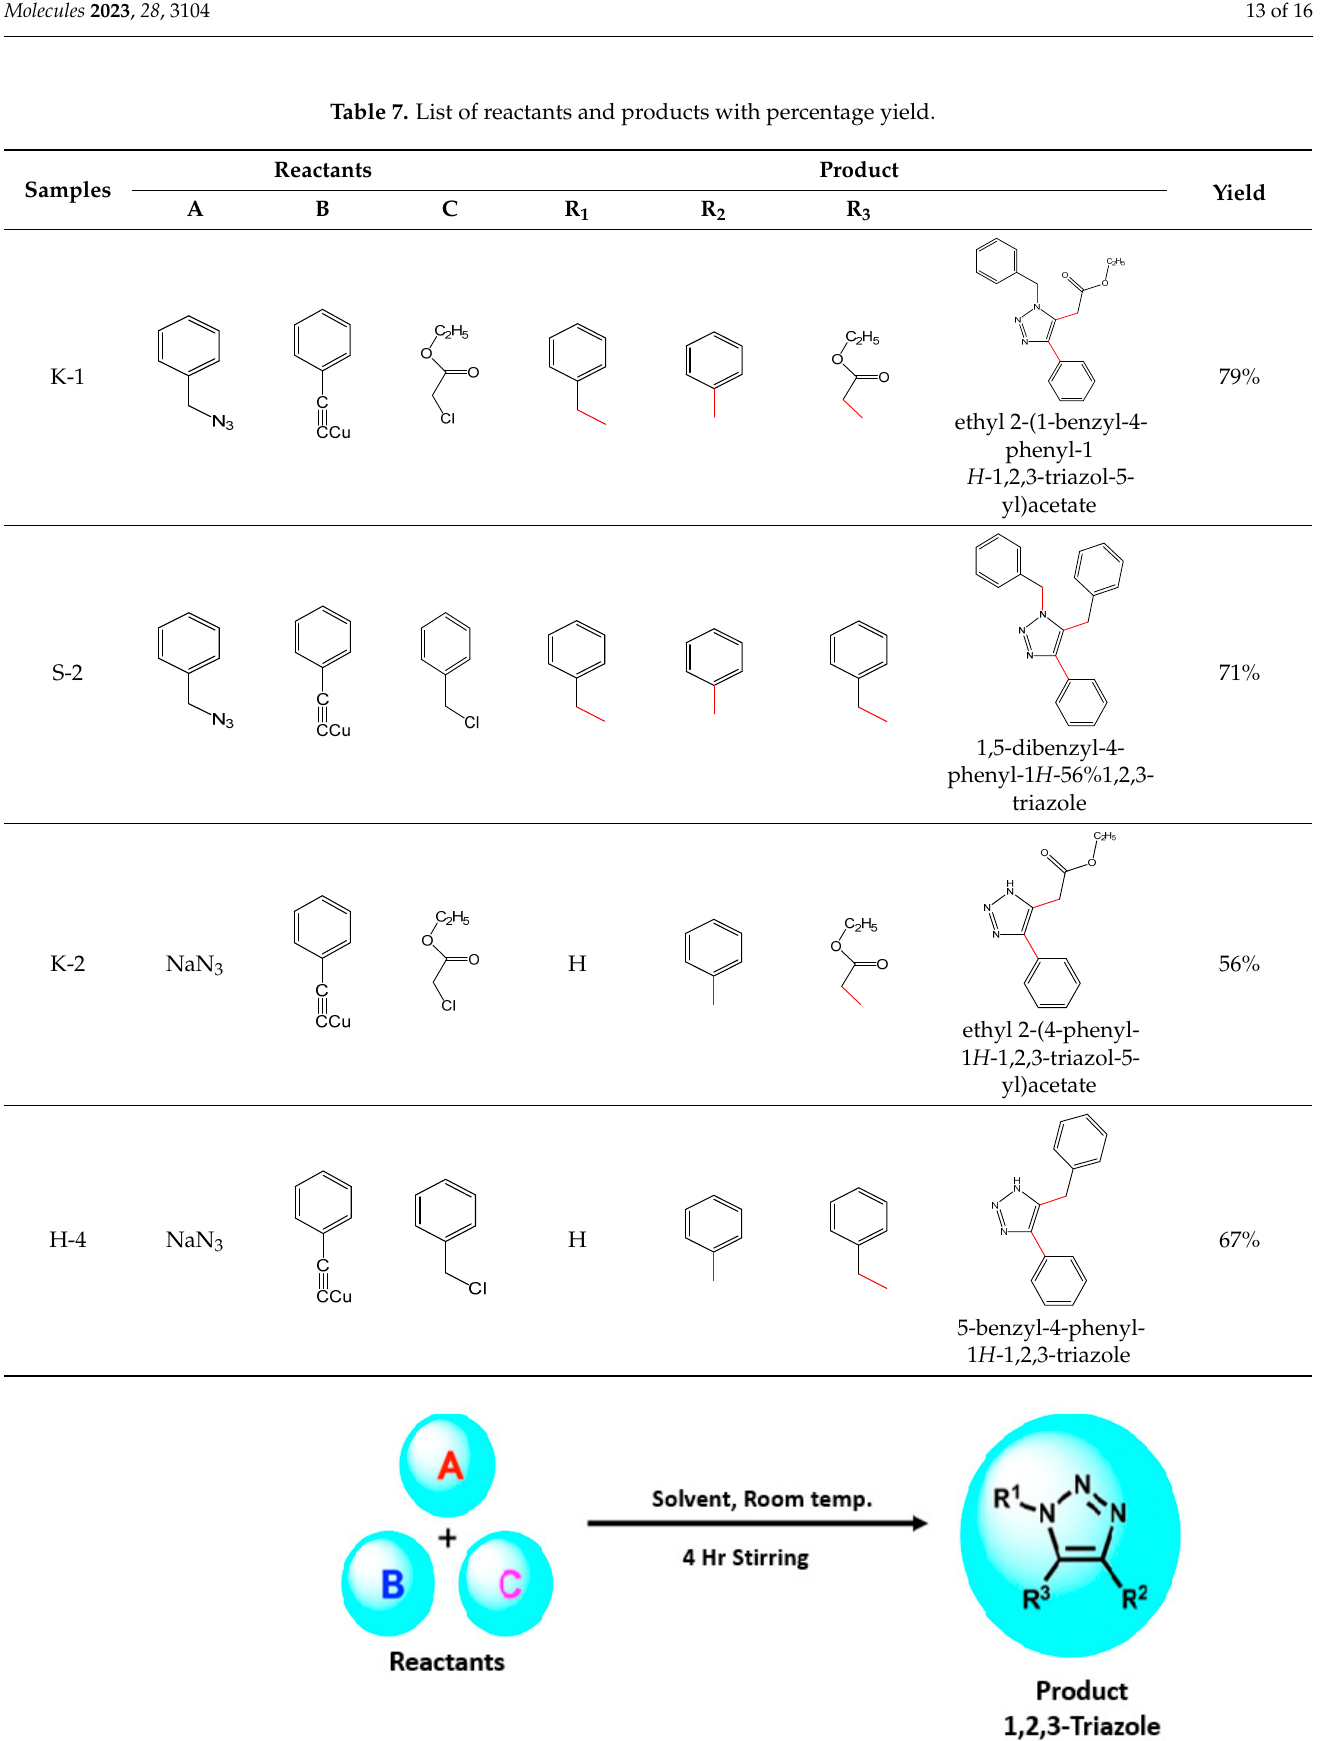
Figure 5. General scheme for the synthesis of triazole. Table 7. List of reactants and products with percentage yield .